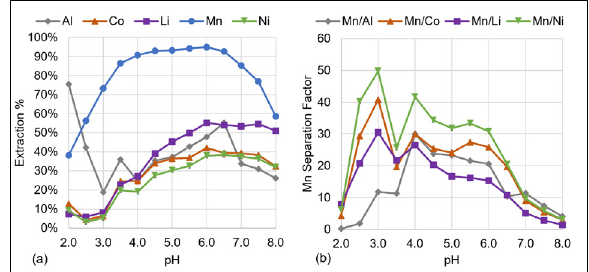
Figure 6: Effect of pH on the (a) extraction efficiency and (b) Mn separation factor of PC-88A. The metal extraction from citric acid media using PC-88A observed in this study also greatly deviates from the metal extraction in sulfuric acid. Using PC-88A in sulfuric acid media, Zhao et al. 44 found the pH and Co 2+ to be 4.15 and 4.75, respectively. However, in this study, the pH in citric acid media for Mn 2+ was 2.1, while 50% Co 2+ extraction 50 was not achieved within a pH range of 2 to